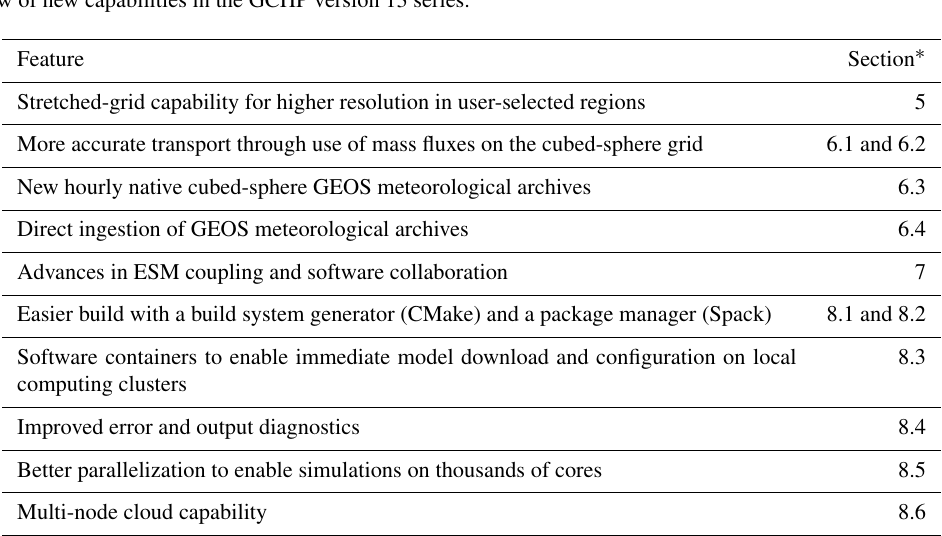
Table 2. Overview of new capabilities in the GCHP version 13 series.